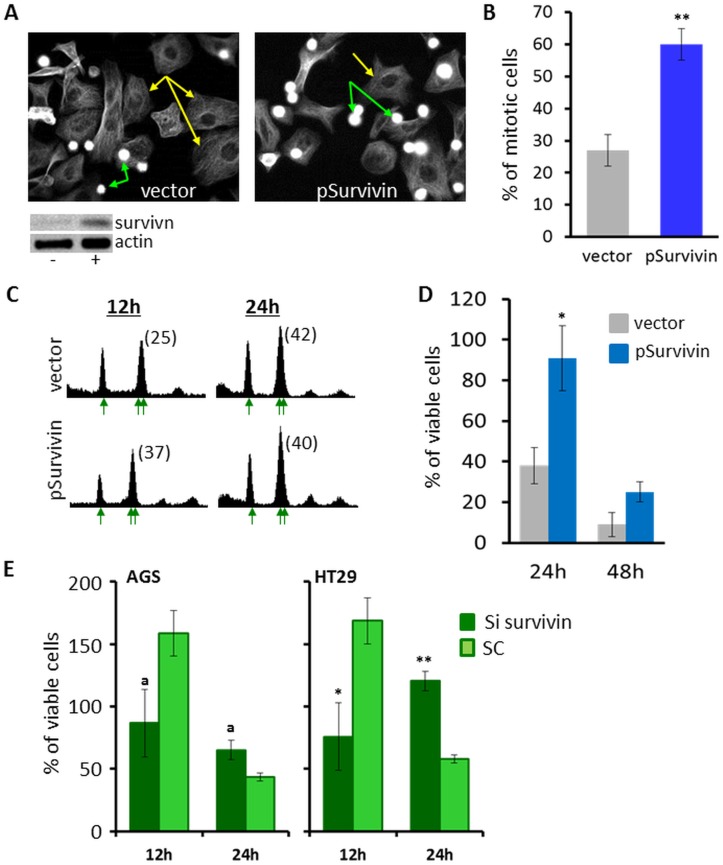
Elevated expression of survivin induces mitotic arrest and increases cell viability in the presence of monastrol.(A–D) AGS cells were stably transfected with a plasmid expressing GFP (vector) or a plasmid that encodes for overexpression of survivin-GFP (pSurvivin). Cells were treated with 100μM monastrol and processed for microtubule immunostaining (A and B), cell-cycle distribution analysis (C), and viability test (D). (A) Representative images of microtubule cytoskeleton in AGS cells carrying an empty vector or pSurvivin, indicated at the bottom. Cells were treated with 100μM monastrol for 24h. G1-like cells (yellow arrows) and mitotic cells (green arrow) are observed. Since the mitotic cells are round, their focal plane is different from that of the flat G1-like cells. Images in (A) are focused on the G1 cells and therefore the monoasters in mitosis are not seen in these images. Consequently, mitotic cells appear as bright spheres (green arrows). Bottom: survivin WB analysis of proliferating AGS cells in the presence (+) or absence (-) of the pSurvivin overexpression plasmid. (B) Quantification of % of mitotic cells based on images such as shown in (A). Gray—vector only; blue—pSurvivin. Columns and bars represent averages and SEM of three independent experiments in which a total of 200–300 cells were counted. **P<0.01, compared to vector only. (C) Stably-transfected AGS cells were treated with monastrol for 12h and 24h (indicated on top) and processed for cell-cycle phase distribution analysis by flow cytometry. Single and double arrows represent peaks with 2n and 4n DNA content, respectively. Numbers in parentheses represent the percentage of cells with double (4n) DNA content. (D) Viability of stably transfected cells in the presence of 100μM monastrol for 24h and 48h. Gray—vector only; Blue—pSurvivin. The number of viable cells was determined by XTT assay for mitochondrial activity. Percent of viable cells was calculated relative to control experiments with DMSO only. Columns and bars represent average and SEM of 3 independent experiments. *P<0.05, compared to vector only. (E) AGS and HT29 cells were transiently transfected with survivin (dark green) or scrambled (SC, light green) Si RNA sequence. 12h following transfection AGS and HT29 cells were treated with 100 and 150μM monastrol, respectively, for 12h and 24h (indicated on the bottom). Viability of cells was determined by Trypan blue. Percent of viable cells was calculated relative to control experiments with DMSO only. Columns and bars represent average and SEM of 2–4 independent experiments preformed in triplicates. *P<0.05; **P<0.01; a—0.05<P<0.1, compared to scrambled Si RNA sequence.